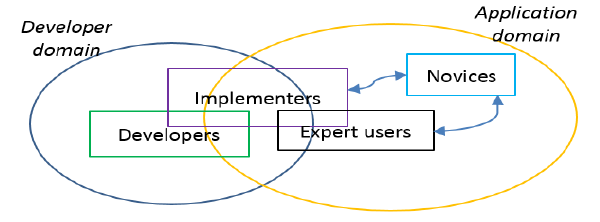
Figure 5. Interactions between developers, implementers and users